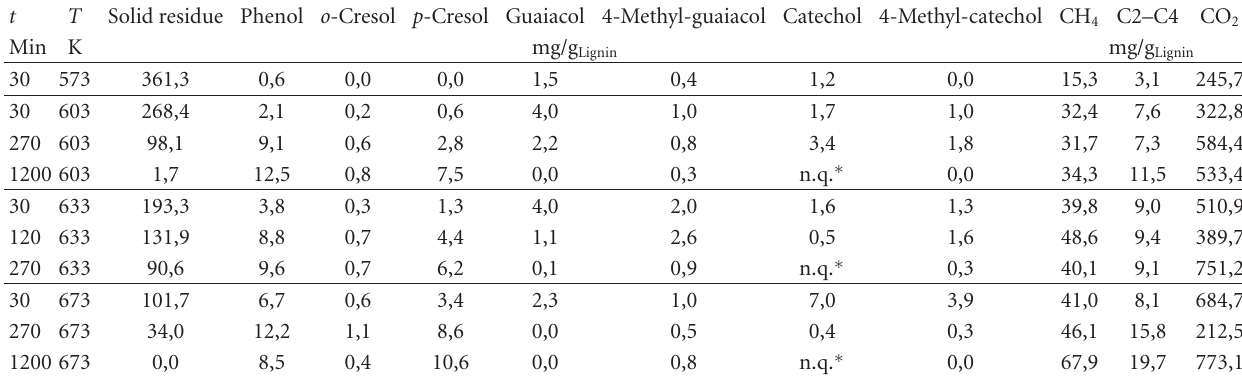
Table 4: Results of hydrothermal lignin degradation experiments, input: 0.4 g lignin, 0.1 g RANEY Nickel, 3g H 2 O.